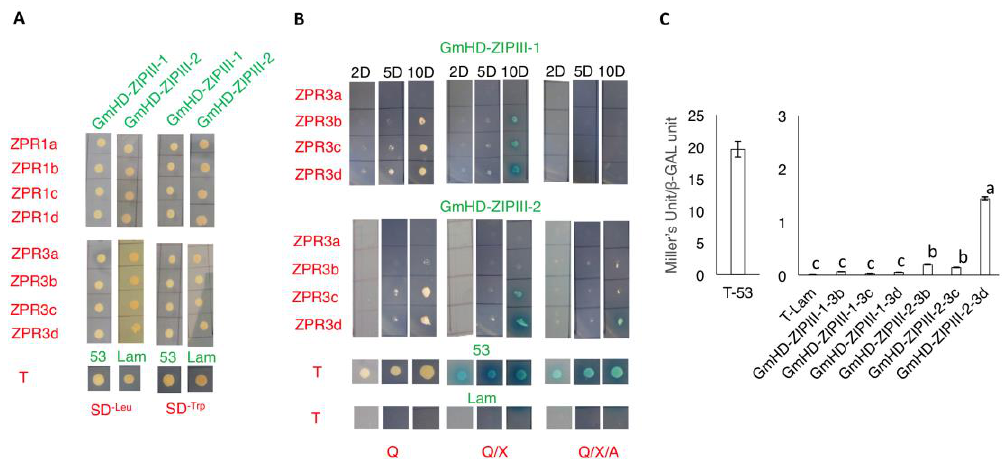
Figure 2. Interaction of GmZPRs with GmHD-ZIP III-1 and -2 in yeast-2-hybrid assays. ( A ) Colonies of mated yeast cells containing GmHD-ZIPIII-1 or -2 and one of the GmZPRs grown on SD-leu and SD-Trp. Yeast cells containing T-53 and T-Lam were used as positive and negative controls respectively. ( B ) Colonies of mated yeast cells containing GmHD-ZIP III-1 or -2 and one of the GmZPR3 family members grown on different assay plates imaged at 2, 5, and 10 days after plating. Q refers to minimal media without Leu, Trp, Ade and His; X- with X- α -Gal; and A-with Aureobasidin. Yeast cells containing T-53 and T-Lam were used as positive and negative controls respectively. ( C ) β -GAL activity of mated yeast cells containing GmHD-ZIPIII-1 or -2 and one of GmZPR3b, 3c, or 3d assayed using a spectrophotometric assay. Yeast cells containing T-53 and T-Lam were used as positive and negative controls respectively. Data shown are average Miller’s units normalized to yeast cell concentration from three replicate assays. Error bars indicate SE ( n = 3). Samples marked with different letters are significantly different from each other based on One-way ANOVA and Tukey HSD test.